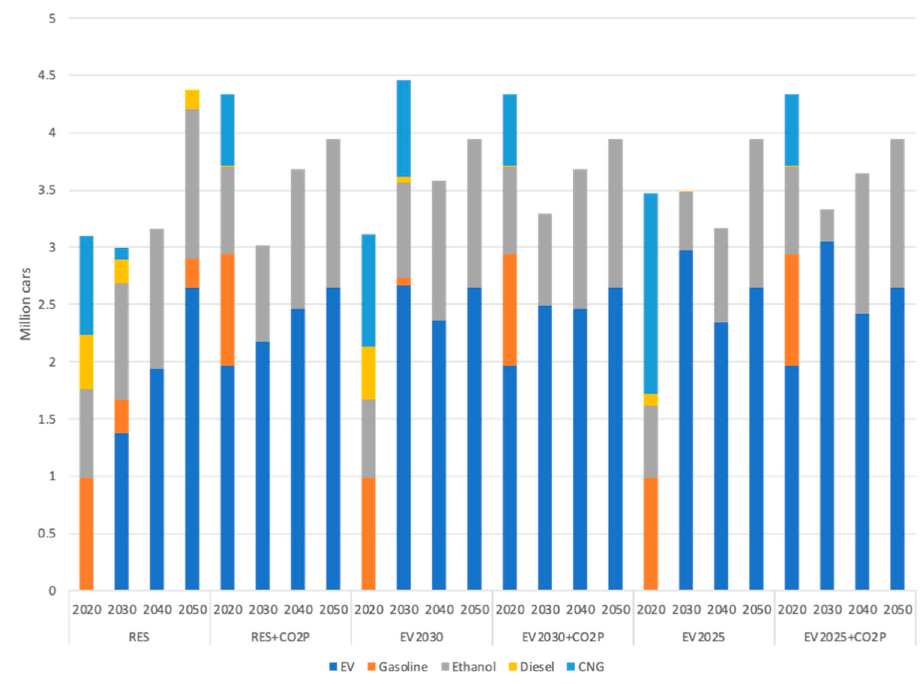
Figure 6. Light-duty vehicle fleet composition (million cars) by scenario and year.